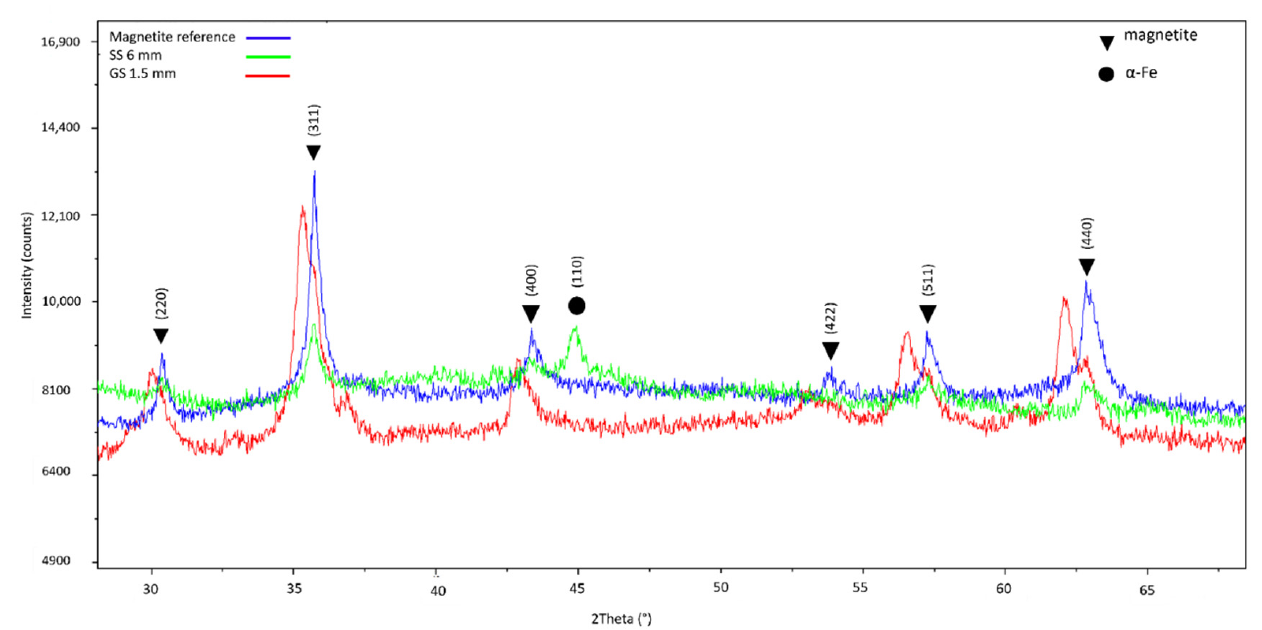
Figure 4. X-ray diffraction patterns for magnetite reference material and PM collected from cutting on GS 1.5 mm and SS 6 mm.